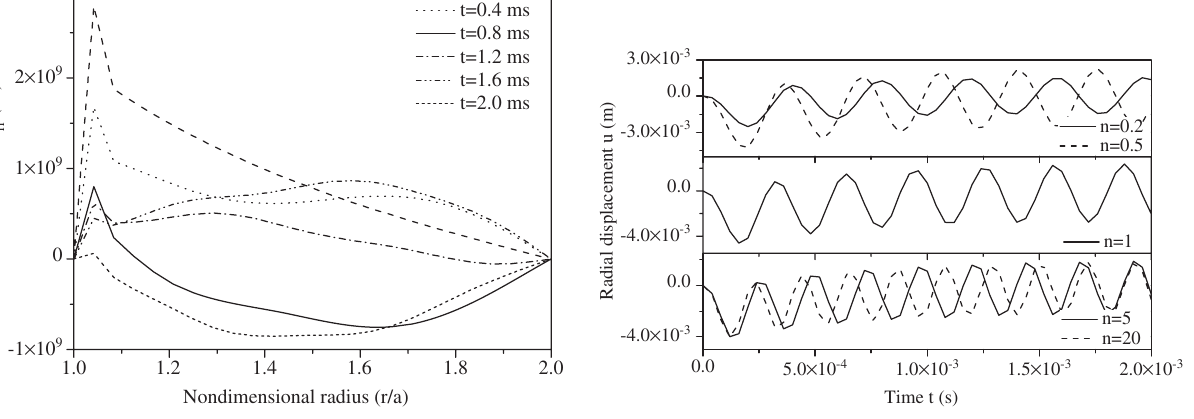
Figure 9 Distributions of radial stress in the FGM hollow cylinder at different times, where n = 1.